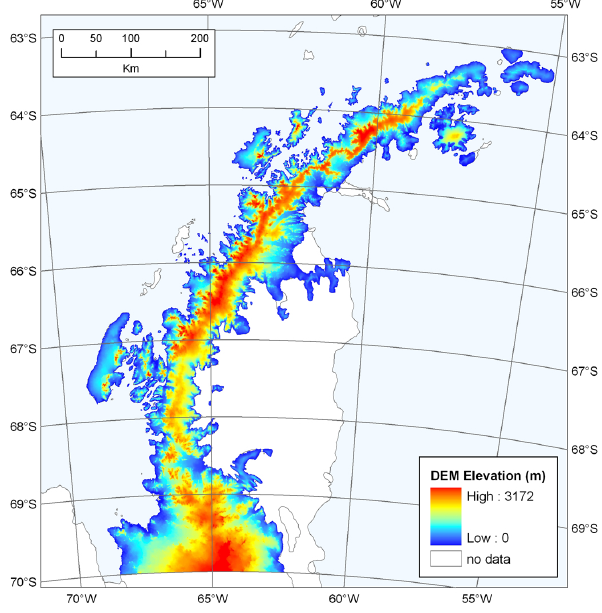
Figure 4. The new 100-m DEM of the Antarctic